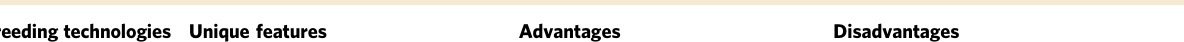
Table 1 Comparison of different plant breeding